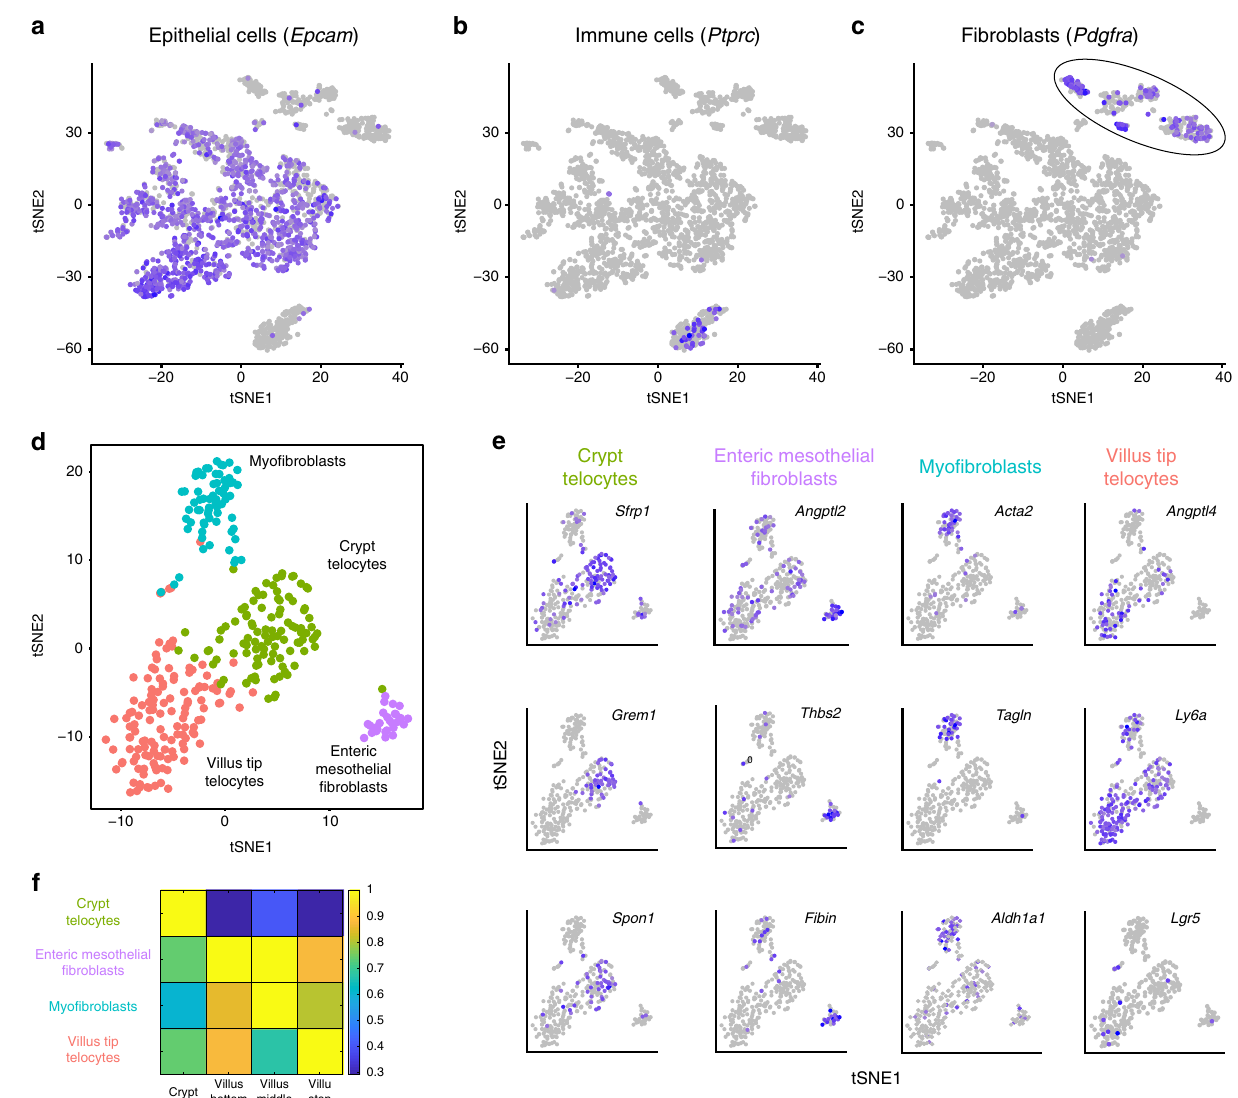
Fig. 4 Single cell transcriptomics of the intestinal stroma identi fi es four spatially-strati fi ed mesenchymal cell populations. a – c tSNE plots of sequenced single cells highlighting the expression of Epcam, an epithelial marker ( a ), Ptprc , encoding CD45, a pan-immune marker ( b ) and Pdgfra ( c ) a mesenchymal marker. Purple hue indicates log expression levels. d tSNE plot of the Pdgfra + cells from the cluster circled in c . Colors denote the identi fi ed four clusters, obtained by re-clustering the Pdgfra + cluster cells in c . e tSNE plots colored by selected markers for the four mesenchymal cell clusters (see Supplementary Fig. 3 and Supplementary data 4 for the complete list of markers). Lgr5 is signi fi cantly enriched in the Villus Tip Telocytes (7 out of 10 Lgr5 + cells belong to the VTT cluster, hypergeometric p = 0.0121). f Summed expression of the top markers for each mesenchymal cell cluster in the LCMseq data, normalized by the maximum across zones